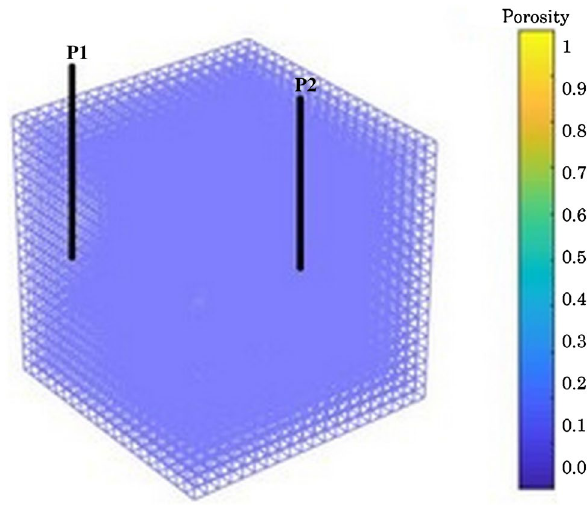
Fig. 17 Cartesian gridding system of case #1